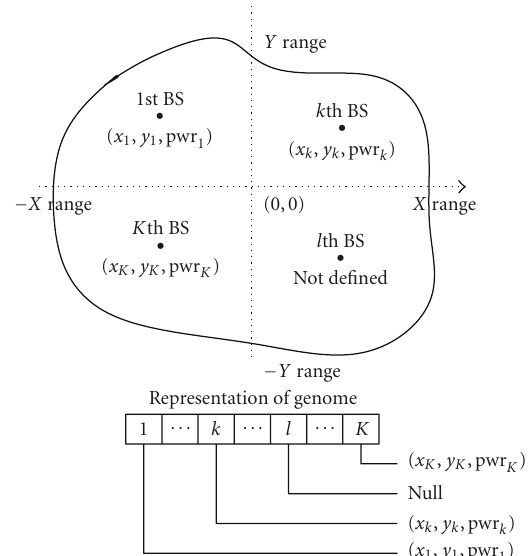
Figure 1: Representation of the genome for the placement of the base station.